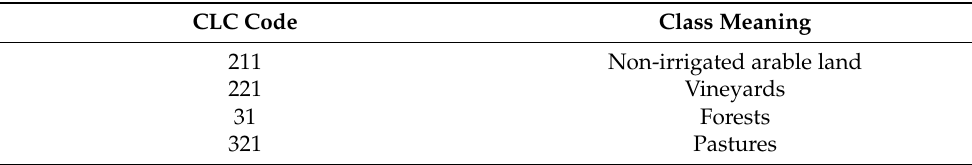
Table 3. CLC code of classes used in this work.